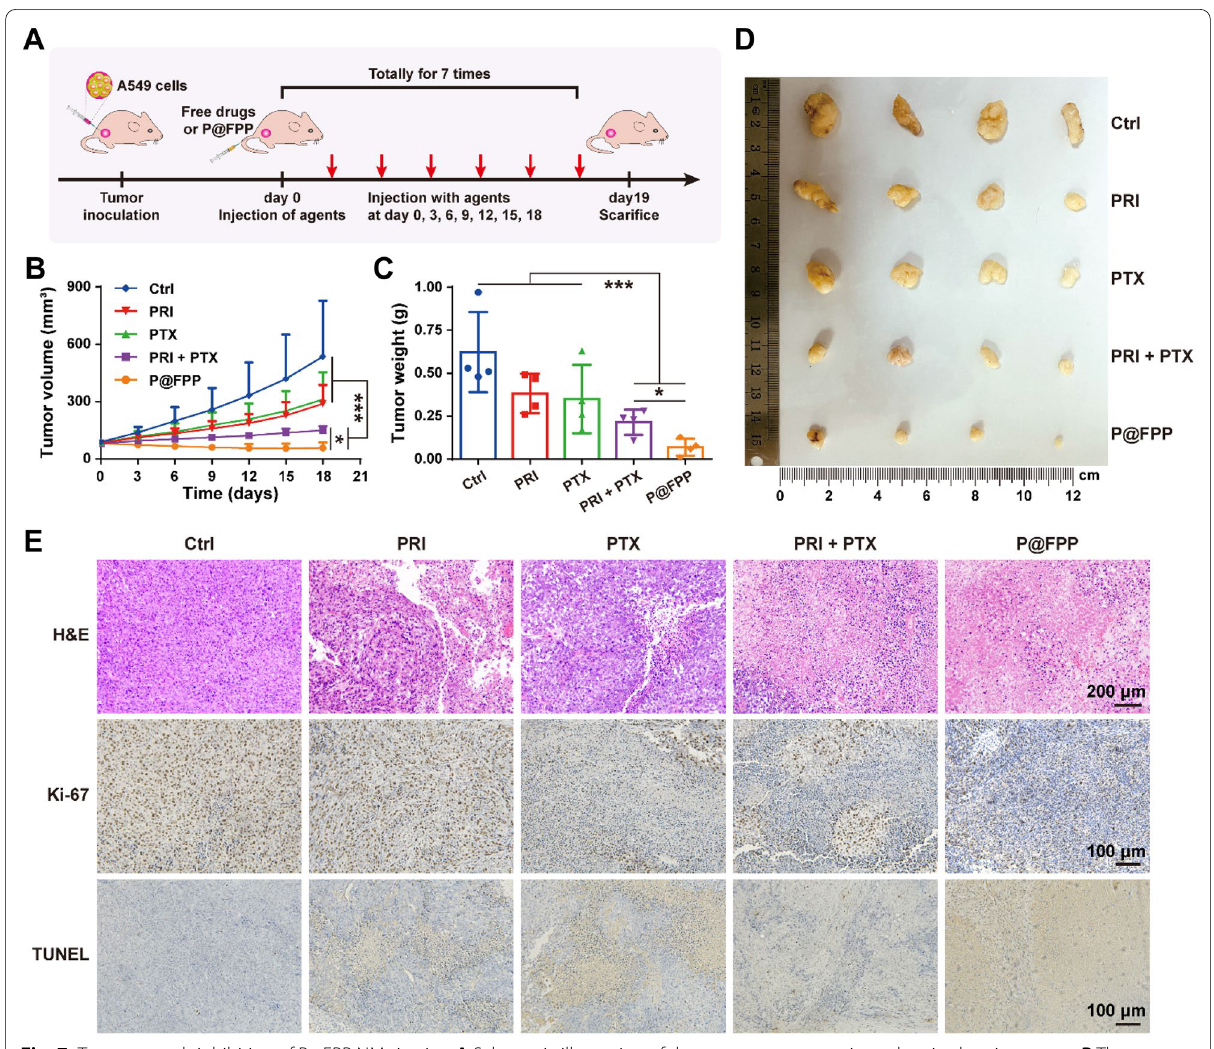
Fig. 7 Tumor growth inhibition of P@FPP NMs in vivo. A Schematic illustration of the treatment process in nude mice bearing tumor. B The changes of tumor volumes under different treatment process (n The physical images of tumors treated with PBS, PRI, PTX, PRI (terminal deoxynucleotidyl transferase–mediated deoxyuridine triphosphate nick end labeling) staining of tumor tissues. scale bar of H&E staining: 200 μm. scale bar for IHC of Ki-67 and TUNEL staining: 100 μm. *: P < 0.05. ***: P <